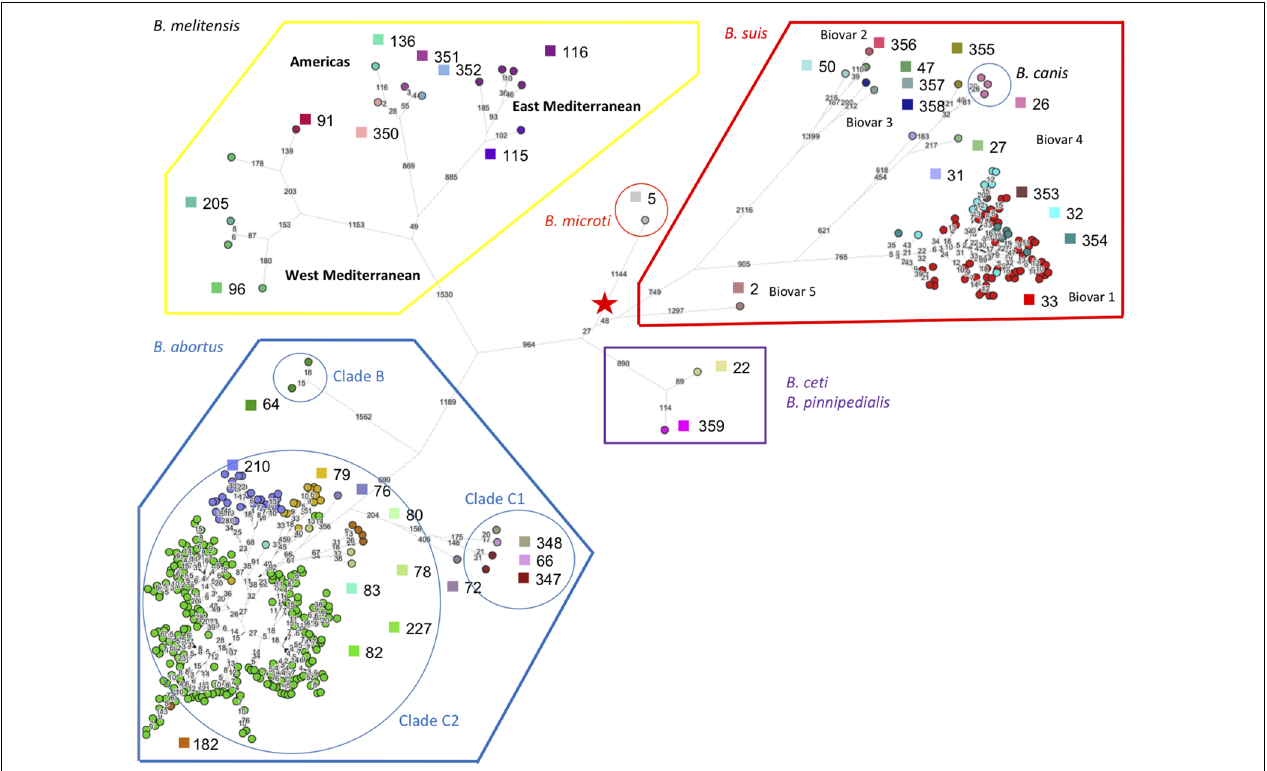
FIGURE 6 | Superposition of whole genome phylogeny and MLVA11 genotypes of phylogeny deduced from whole genome SNP analysis of 355 sequence reads archives and complete genomes compatible with robust in silico MLVA genotypes reconstruction. Three hundred and fifty-five whole genome sequence datasets fulfilled the required criteria for a robust in silico reconstruction of MLVA genotypes, i.e., sufficiently long reads. The datasets were also used for a whole genome SNP analysis as well as for in silico MLST21 genotypes assignment. The color code and associated numbers indicate MLVA11 genotypes. B. abortus B, C1, and C2 MLST clades assignments are indicated. The numbers on branches are the number of SNPs. The length of branches is the square root of the SNP